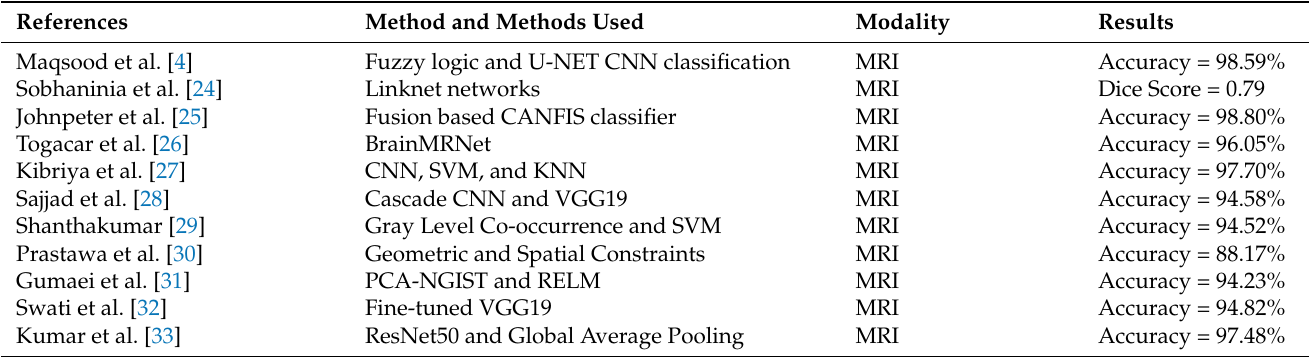
Table 1. Detailed summaries of current research on the detection and classification of brain